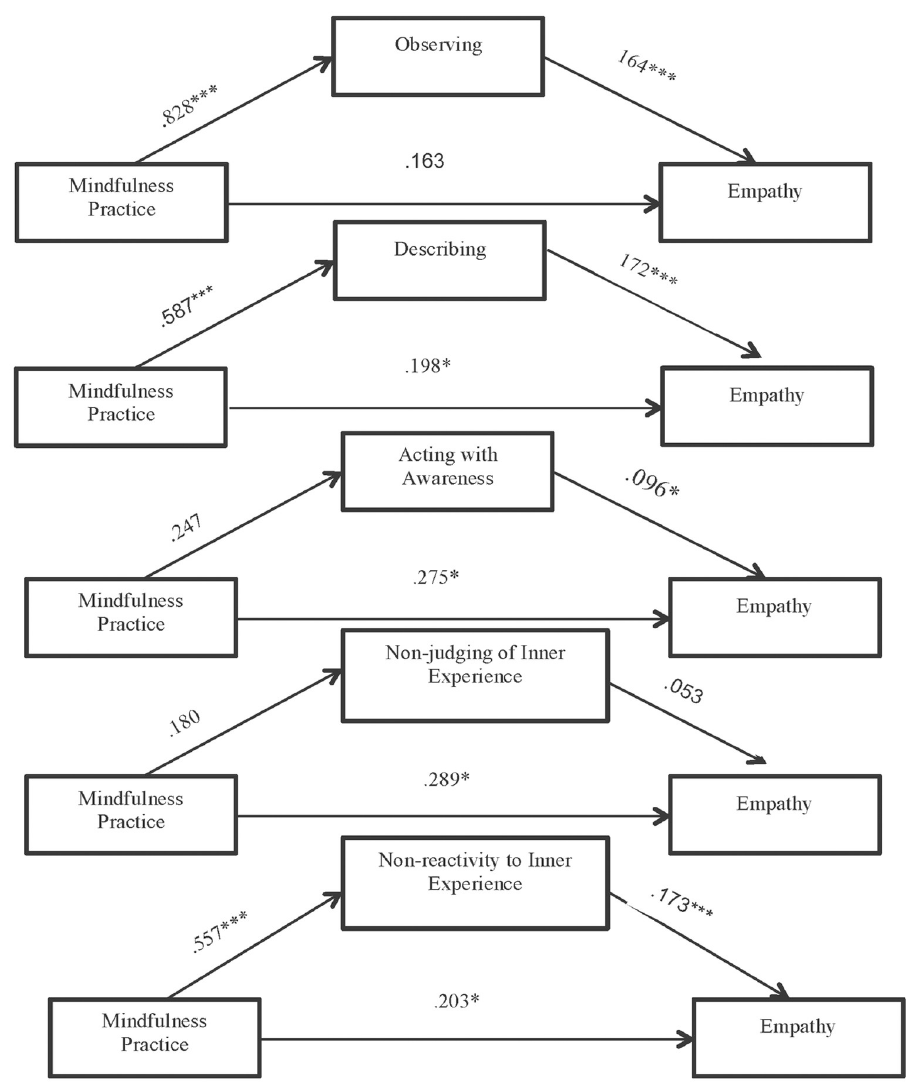
Fig 4. Results of the mediation model: Indirect effect of mindfulness practice on empathy through each mindfulness facets separately (unstandardized regression coefficients) ��� p < .001, � p < .05.